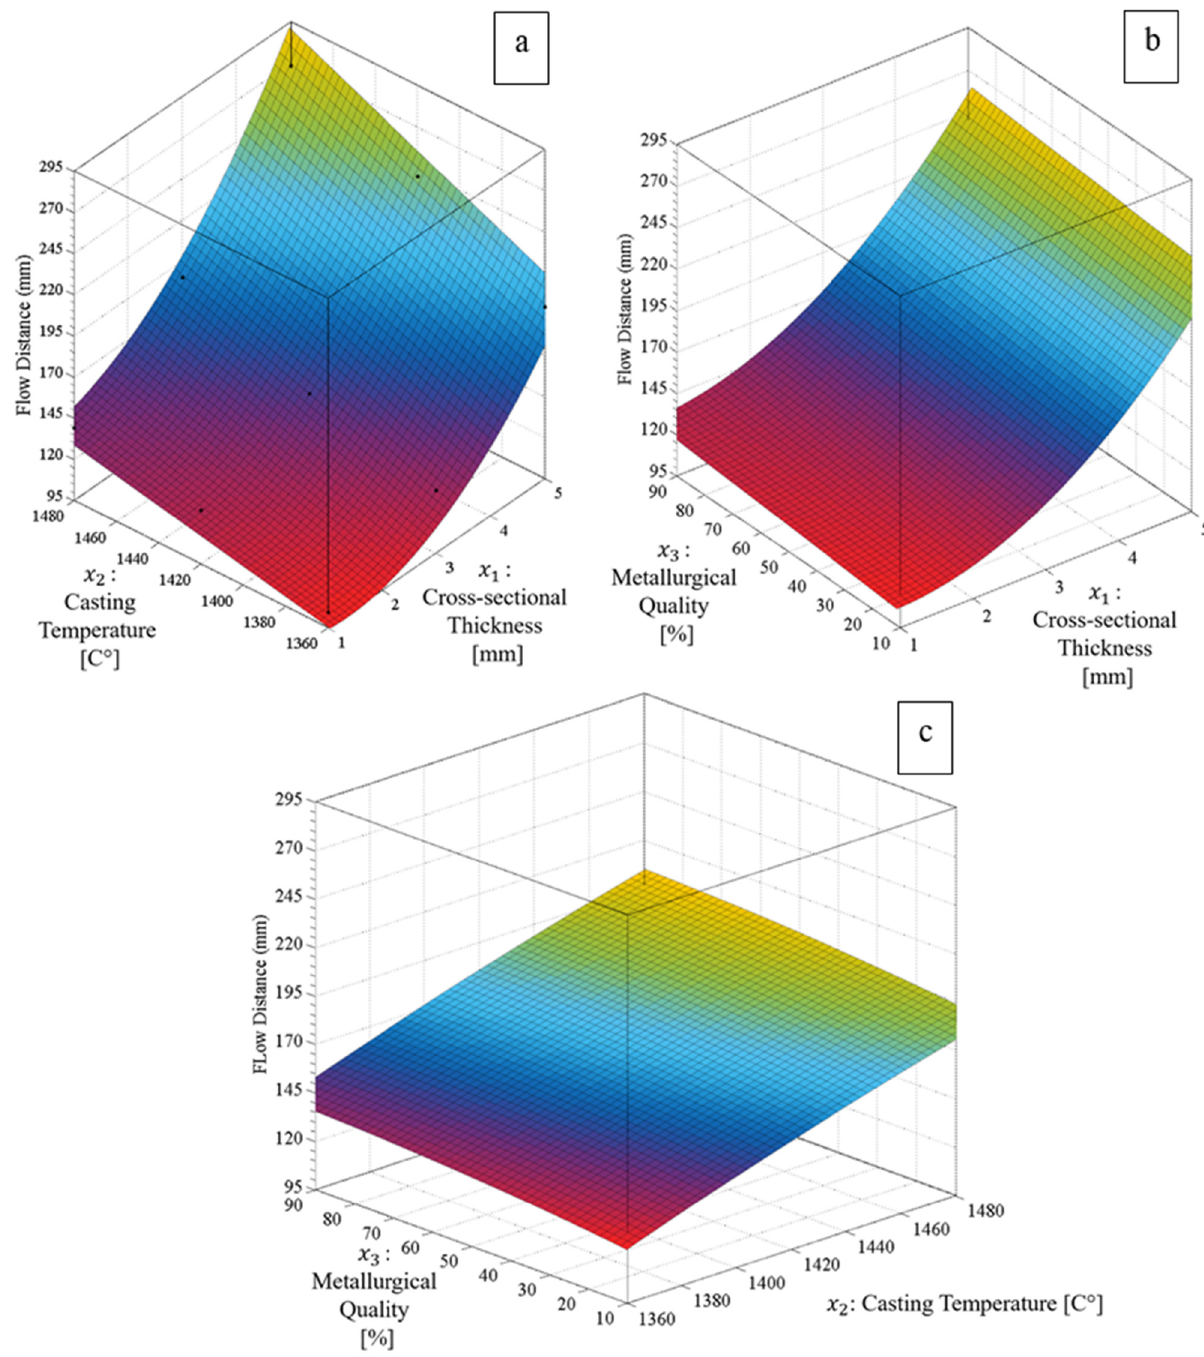
Figure 2: Response surface plots for the interaction e ff ect of ( a ) cross - sectional thickness and casting temperature, ( b ) cross - sectional thickness and metallurgical quality, and ( c ) casting temperature and metallurgical